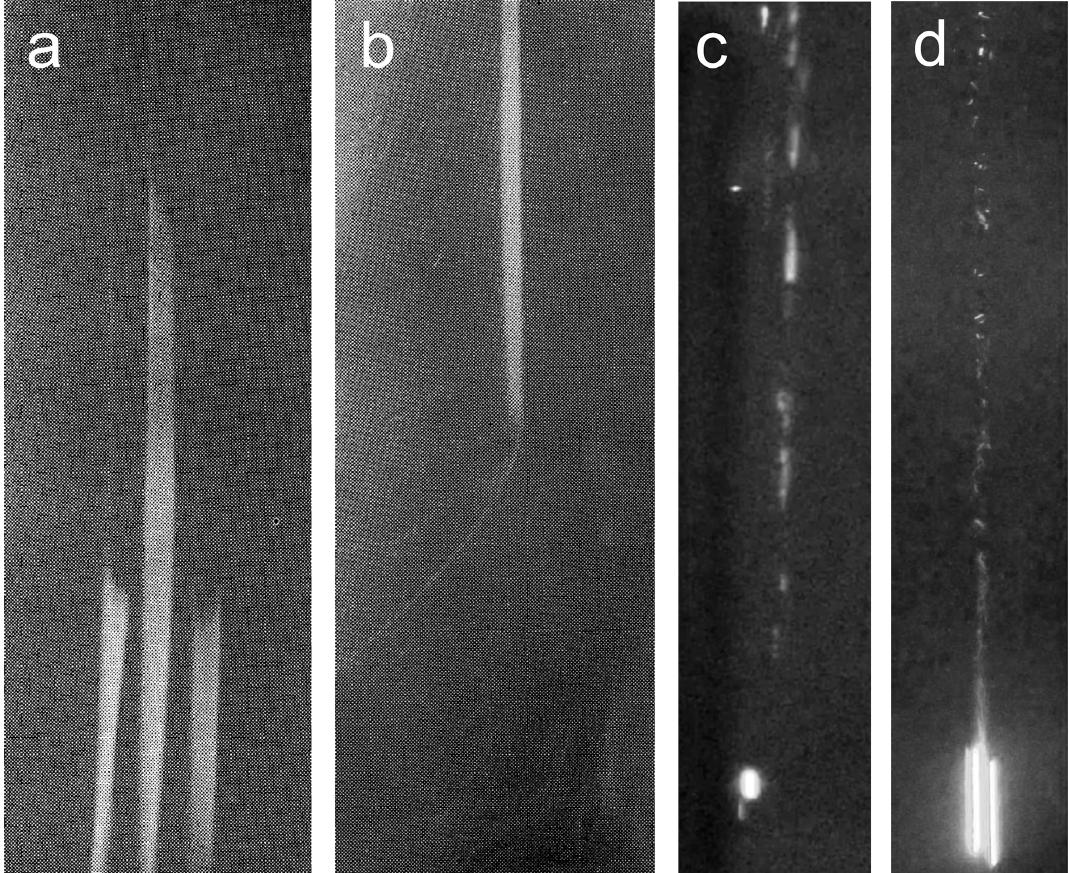
Figure 14. The trajectories of falling drops with D = 100µm visualized by nucleation of CCN and INP in the high supersaturation formed around freezing drops at the moment of (a) initiation of freezing and (b) by the end of freezing at ambient temperature T a ≈ − 65 ◦ C (Iwabuchi and Magono, 1975). Nucleation of water droplets and ice particles in the wake of falling with D ≈ 2mm, (c) T a ≈ − 20 ◦ C, RH w ≈ 60%, and 0 ◦ C < T a < 2 ◦ C; (d) T a = 18 ◦ C, RH w = 60%, and T s = 10 ◦ C. In these experiments AgI and of Snomax were used as ice nuclei (Prabhakaran et al.,